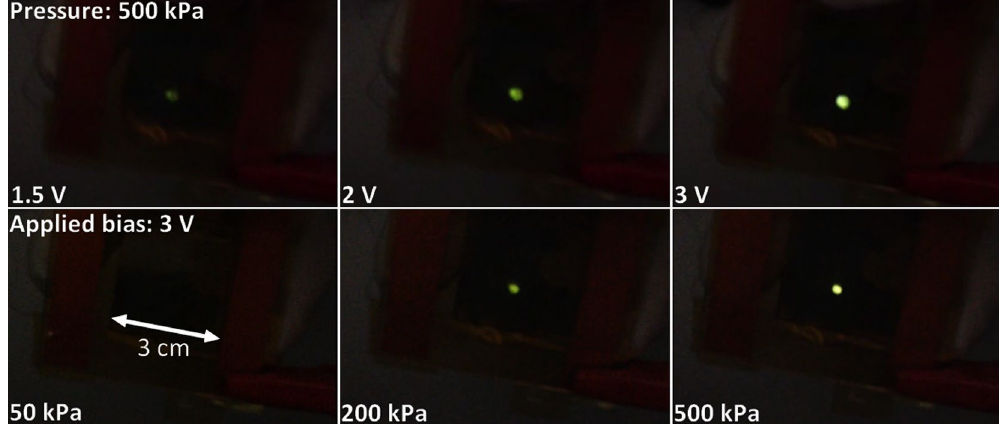
Figure 3. Observed electroluminescence in micro-structured solution-processed light-emitting pressure sensors (top) at constant pressure with increasing bias or (bottom) at constant bias with increasing pressure.